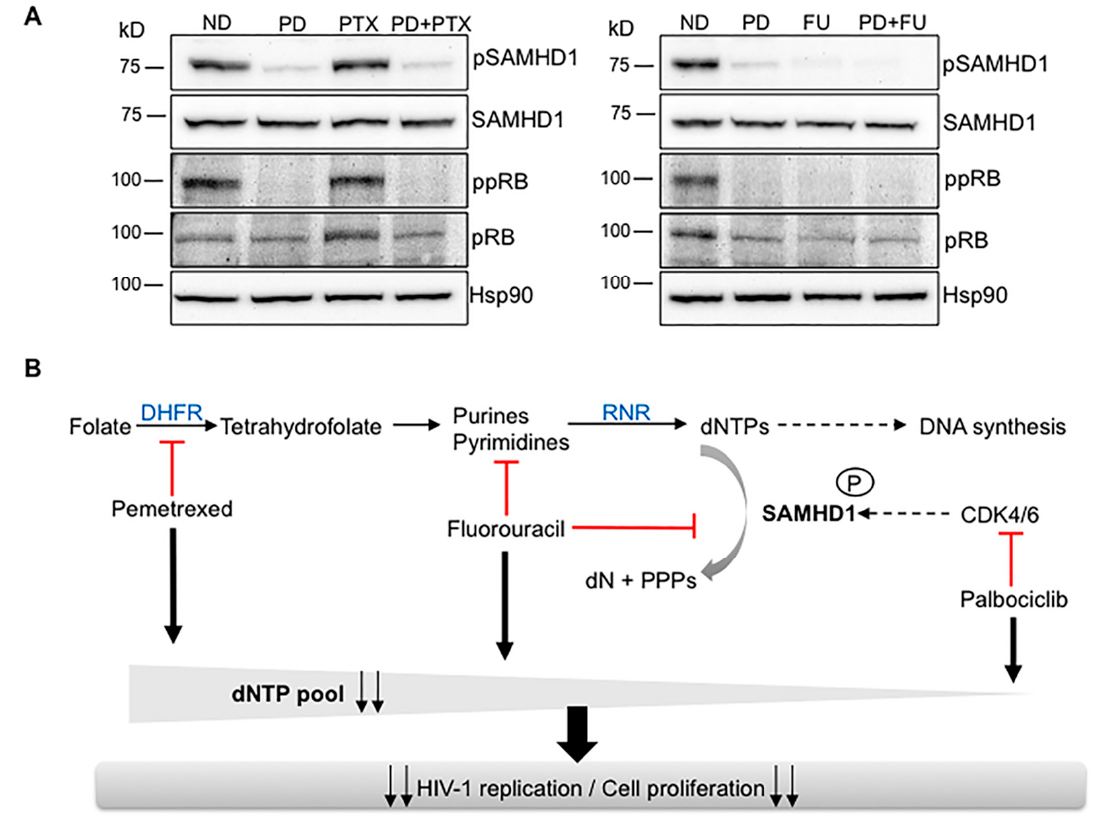
Figure 6. Regulation of dNTP pool is responsible for drug synergy. ( A ) Protein expression in MDMs treated with palbociclib (PD) at 1 µ M, pemetrexed (PTX) and fluorouracil (FU), both at 5 µ M and the corresponding drug combinations PD + PTX and PD + FU. Hsp90 was used as a loading control. A representative blot is shown. ( B ) Proposed model of drug interactions. Antimetabolites a ff ecting dNTP synthesis such as pemetrexed inhibit dNTP pool by a mechanism not directly a ff ecting SAMHD1 activation and thus synergy with anticancer drugs a ff ecting SAMHD1 phosphorylation as palbociclib is higher compared to compounds also targeting SAMHD1 function (i.e., fluorouracil) or exclusively a ff ecting SAMHD1 (i.e., midostaurin). As a consequence, the antiviral and cytotoxic e ffi cacy of antimetabolites is significantly enhanced when used in combination in